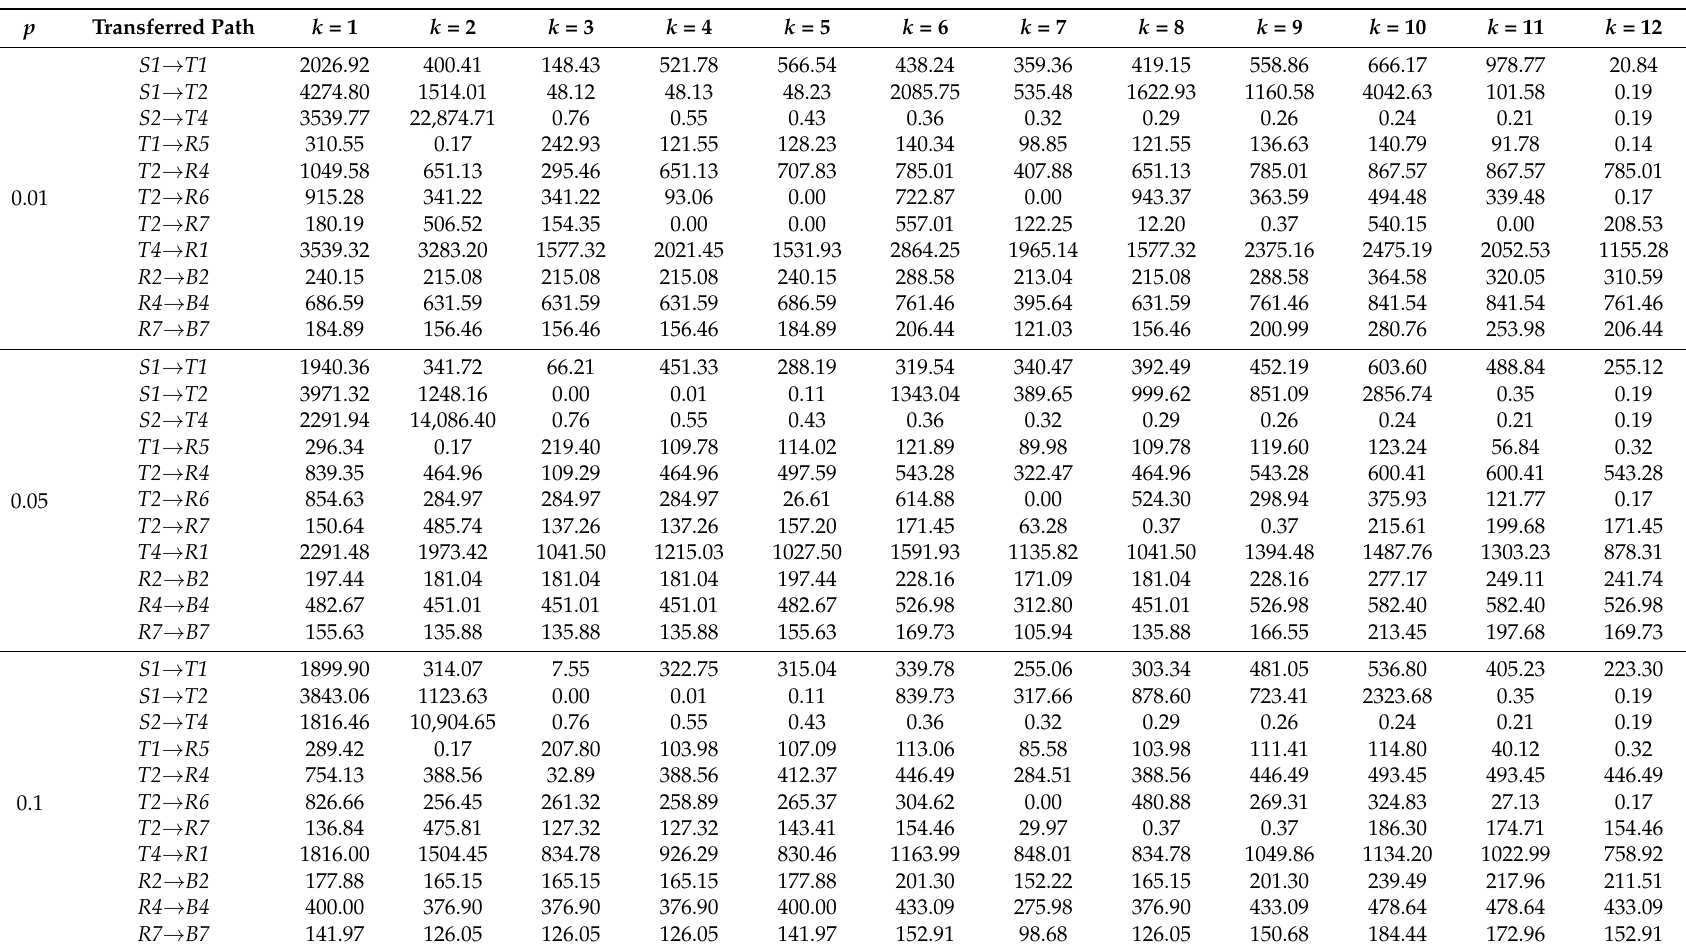
Table 4. Part of the solutions from the SMOCCP model under three constraint-violation levels at w 1 = 0.9 and w 2 = 0.1 ( × 10 3 m 3